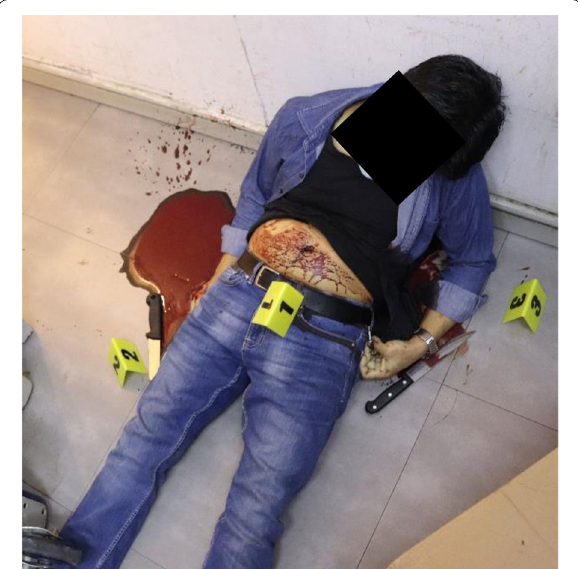
Fig. 1 The position of the victim at the death scene where the body was seen seated on the floor in a semi-sitting position surrounded by two pools of the blood, fully dressed in the opened shirt and raised T-shirt on the abdomen